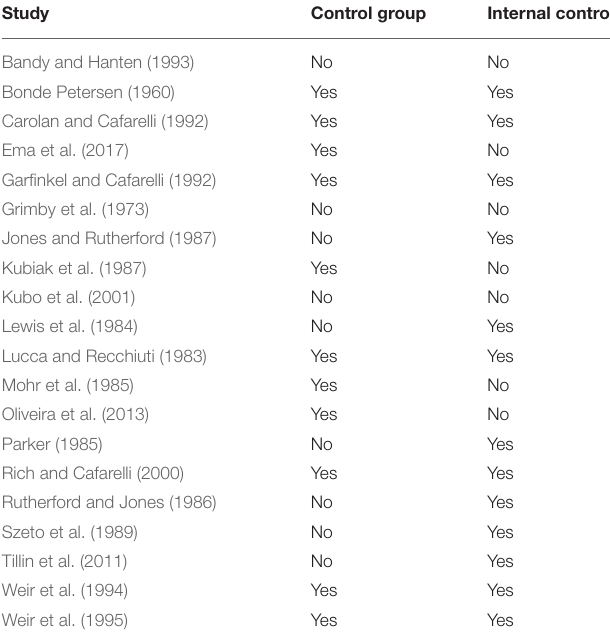
TABLE 1 | Breakdown of studies included in the review and if they report data on a control group or the untrained leg (internal control). Study Control